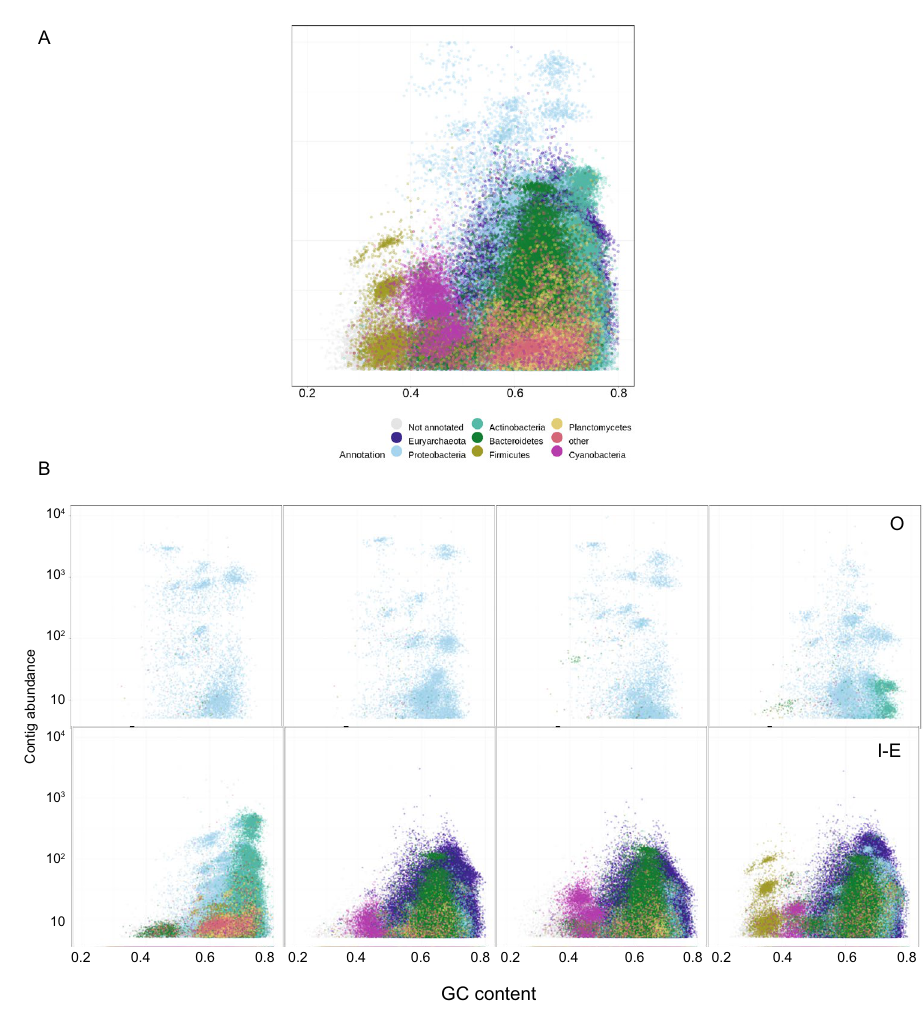
Figure 3. Blob plot of abundance versus GC content. ( A ) Blob plot of inside-edge and outside combined depicting different phylum’s abundance. ( B ) Separate Blob plot of inside-edge and outside